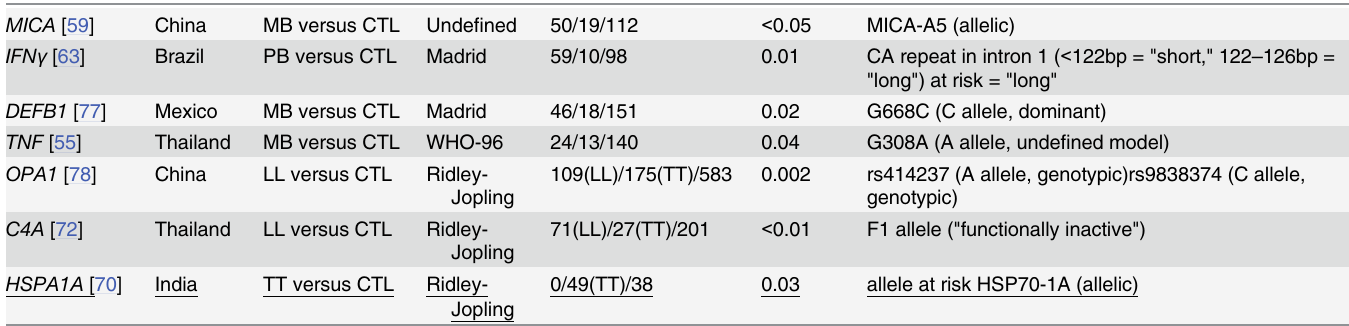
* The table is divided into two panels: upper panel groups are studies that analyzed the polarization phenotype and lower panel groups are those that compared MB or PB patients to controls. Studies are sorted according to their decreased sample size. Bold lines correspond to genes that were identi fi ed by GWAS, and underlining corresponds to studies whose main outcome was to identify genes speci fi c to leprosy polarization or a polar form of leprosy. Hence, all black lines correspond to studies designed to study leprosy per se and a subsequent subgroup analysis for MB, PB, or other polarization